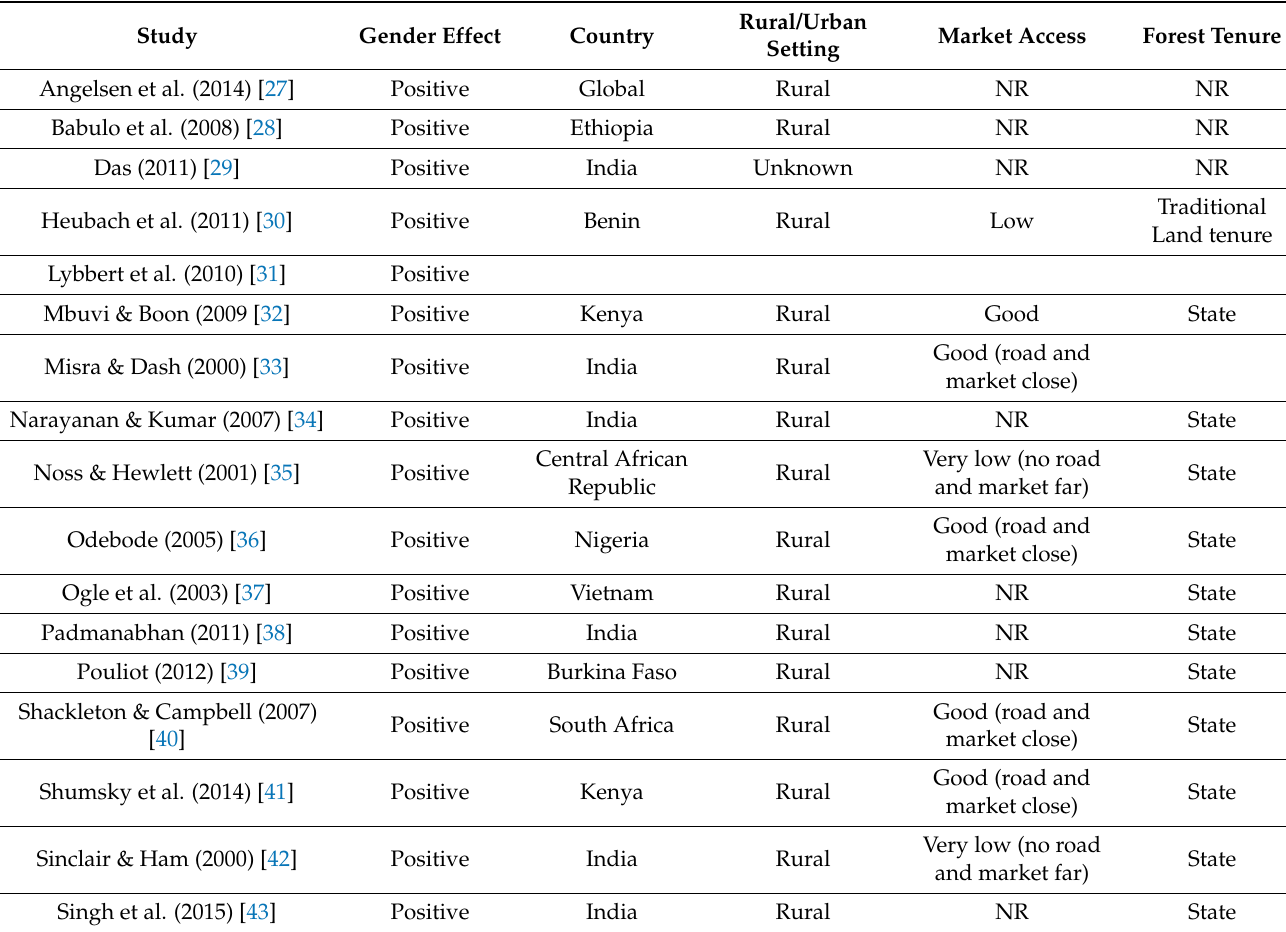
Table 6. Studies reporting positive, neutral/mixed, or negative impact of